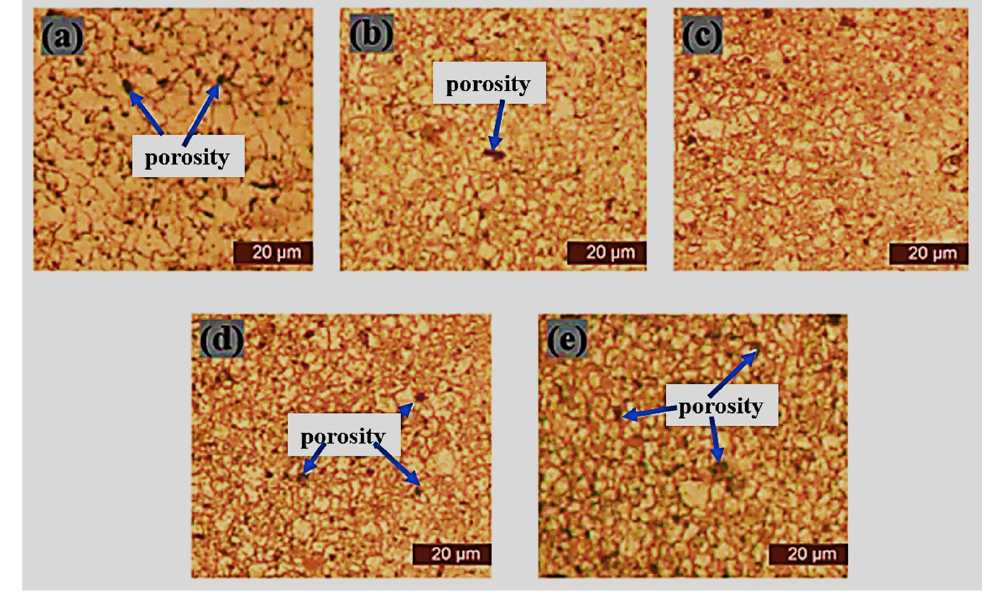
Figure 9. Microstructure of sintered samples ( a ) S1, ( b ) S2, ( c ) S3, ( d ) S4, and ( e ) S5.